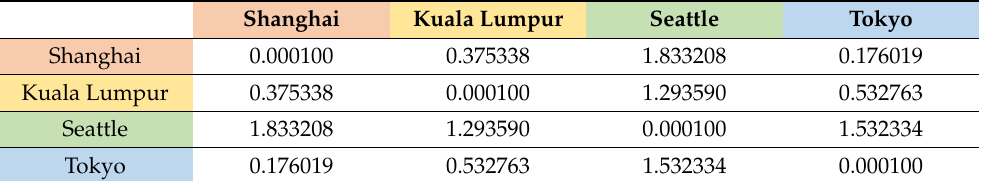
Table A2. Transportation costs of product between factory and market cities